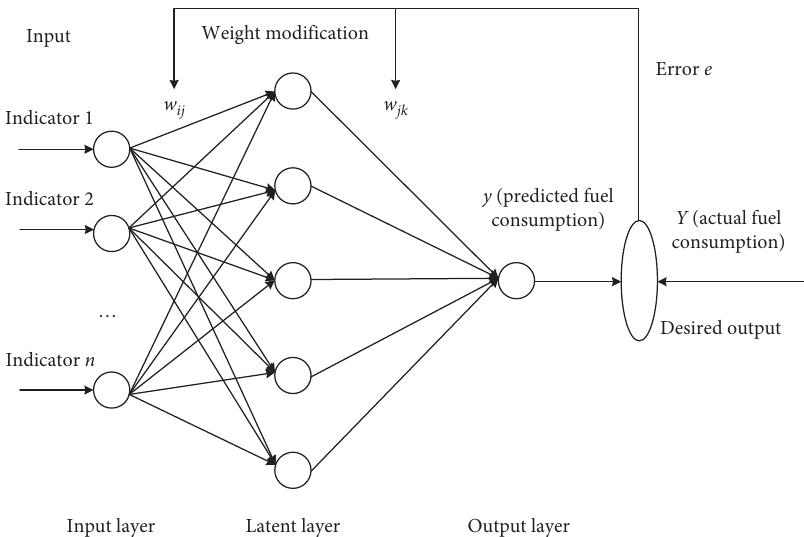
Figure 2: The structure of the vehicle fuel consumption prediction model based on the BP neural network.